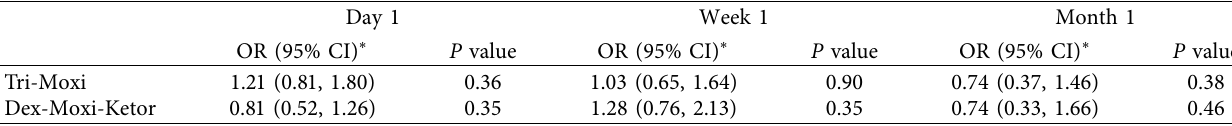
Table 2: Anterior chamber inflammation comparison between compound drugs and standard eyedrop treatment at different time